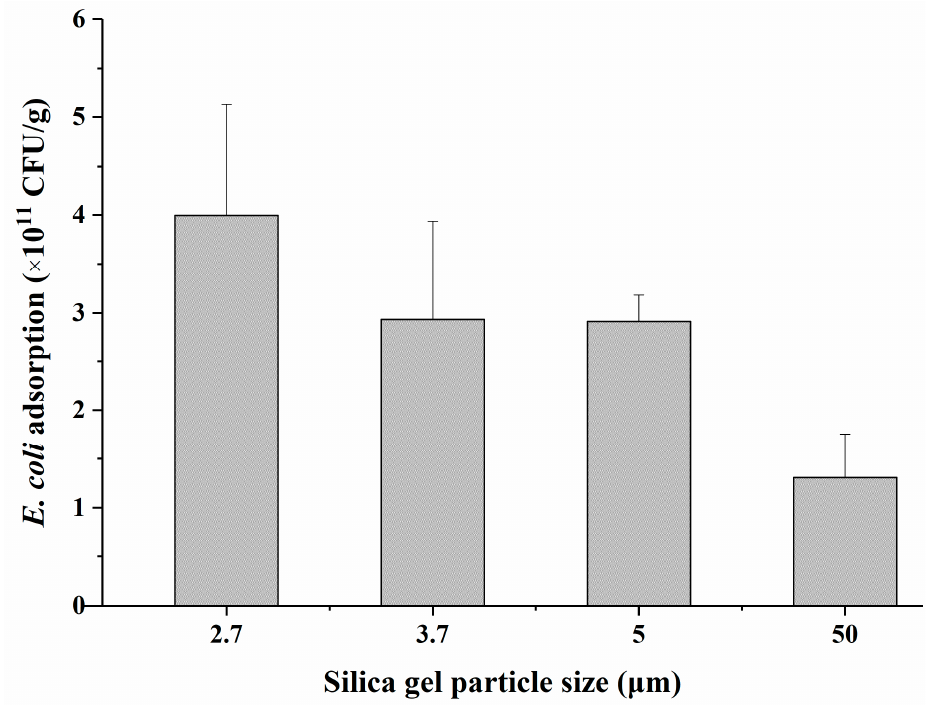
Figure 2. Influence of the use of different particle sizes on the adsorption of E . coli by